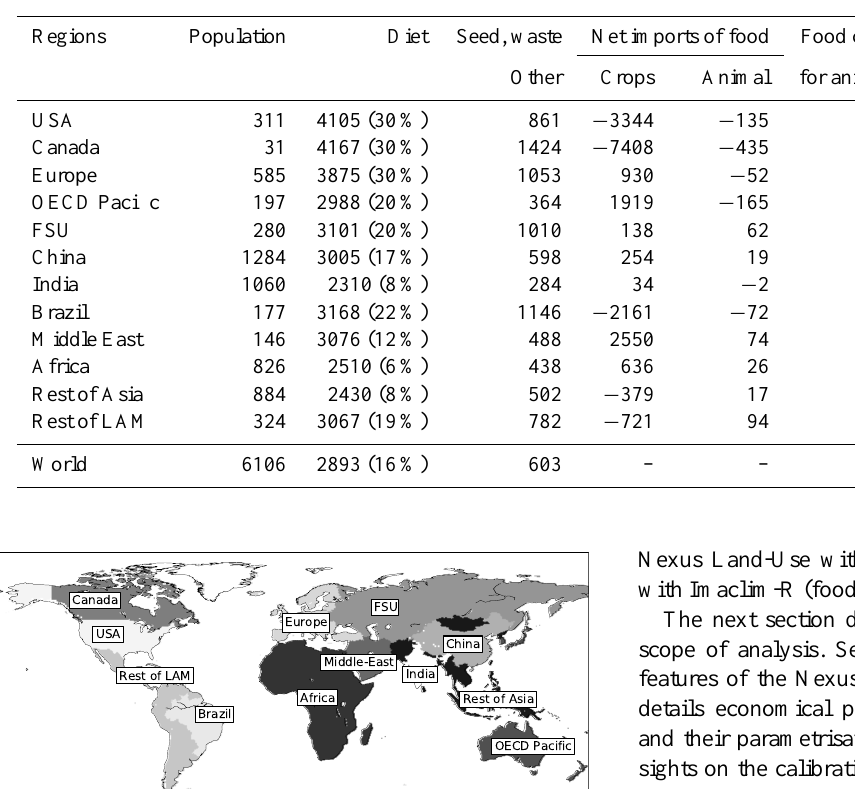
Table 1. Main input data for each region of the model at the base year 2001. Cropland and pasture areas are from Ramankutty et al. (2008) and forests areas from Poulter et al. (2011), other data are from Agribiom (Dorin, 2011). Population is in millions. Diet is calorie consumption in kcal per capita and per day followed by the fraction of animal products in brackets. Consumption for seed, waste at the farm level and other consumption of food crops such as lubricants and cosmetics in kcalcap − 1 day − 1 . Net imports of food crops and animal products in